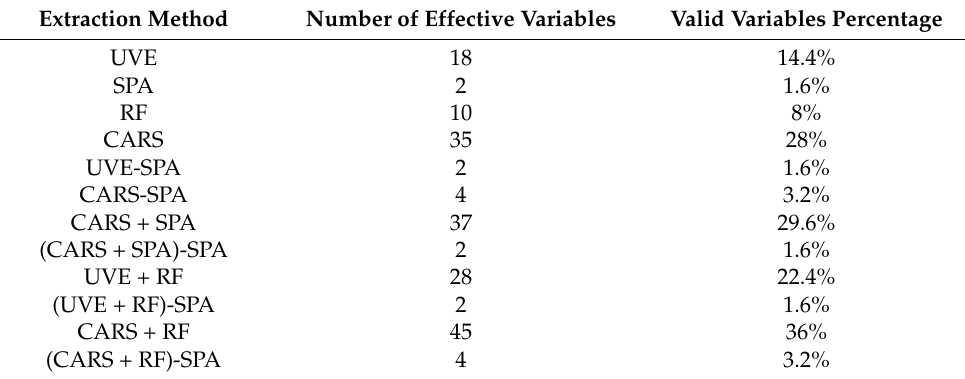
Table 4. The number of feature variables extracted by different feature extraction